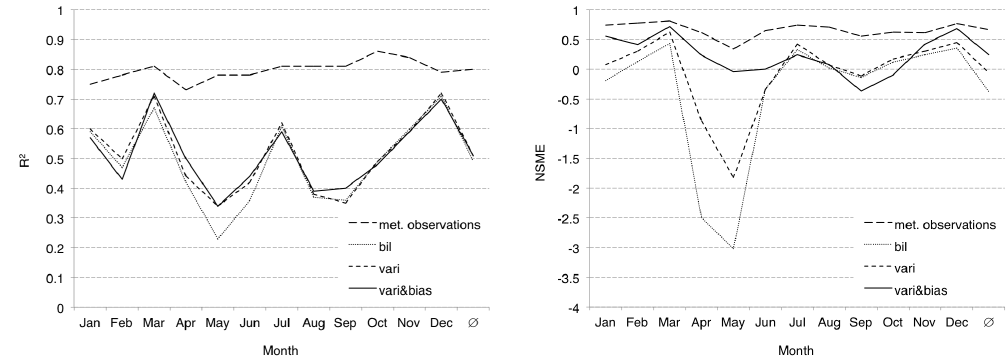
Fig. 8. Performance of the hydrological model PROMET (left: R 2 , right: NSME) for the different months of the year using meteorological observations and ERA40-driven MM5 simulations in combination with different downscaling approaches as meteorological input. The discharge simulations for the downscaling approaches vari and vari&bias have been conducted in two separate model runs (cross-validation) to avoid “in-sample” evaluation. All statistical criteria have been calculated on the basis of the daily discharge conditions 1972–2000 to provide the hydrological model a spin-up time of one